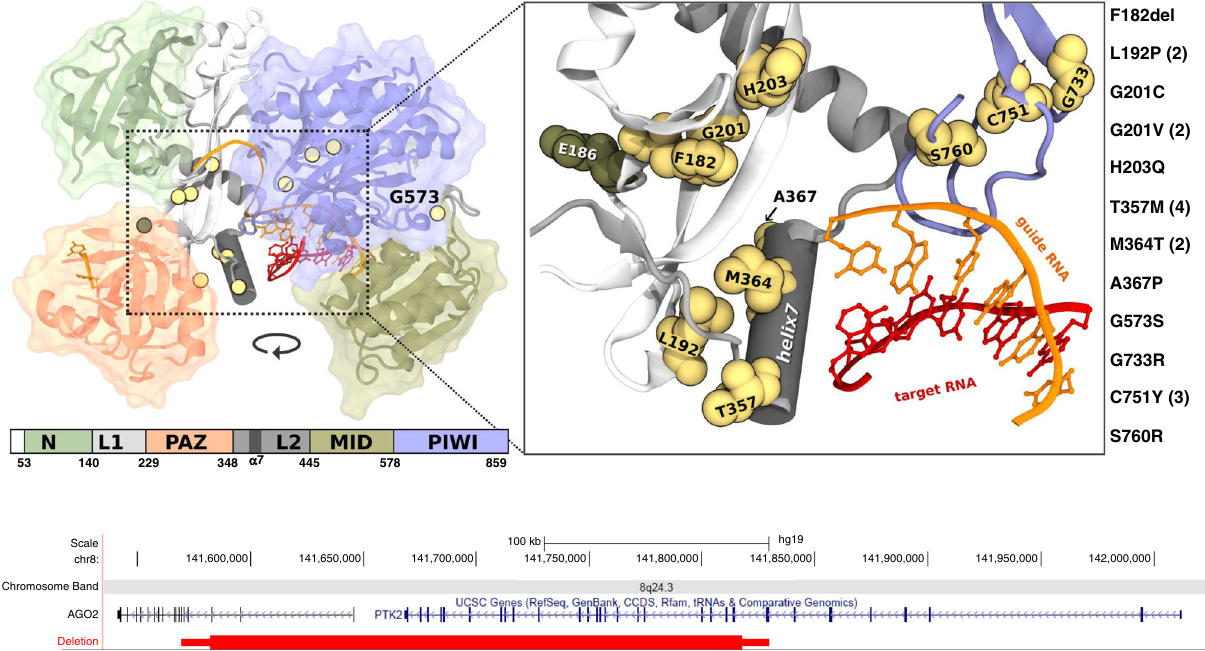
Fig. 1 Location of identi fi ed AGO2 germline mutations. a Domain structure of AGO2 and position of the single amino acid mutations using the structure of human AGO2 in complex with a miRNA and a target RNA 22 . Guide and target RNA are depicted in orange and red, respectively. The recurring mutations are designated in brackets. b Genomic region, chr8.hg19:g.(141,582,269-141,817,600)del, of the 235.3-kb deletion identi fi ed in case 21, involving the fi rst three AGO2 exons and the last 23 PTK2